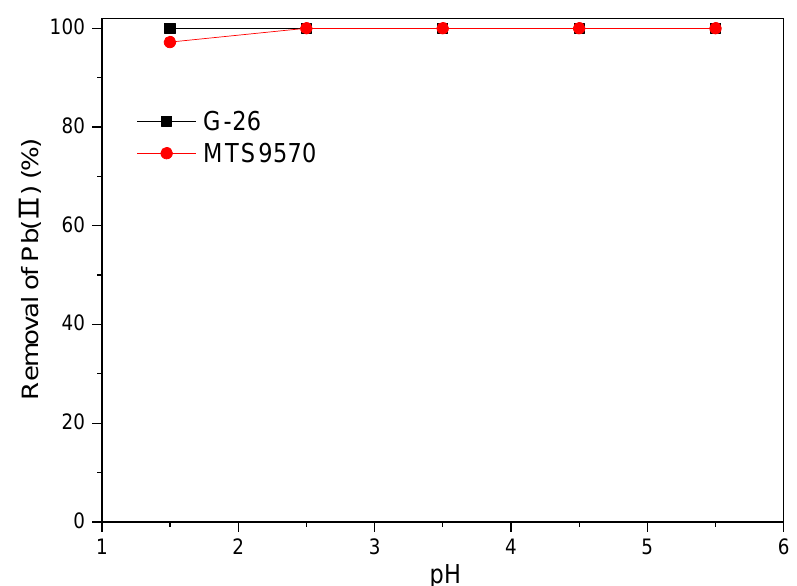
Figure 5. Effect of pH on adsorption of Pb(II) using G-26 and MTS9570 exchange reins at 0.5 g of resin dosage, 20 min agitation time, 150 rpm agitation speed, concentration 1000 mg/L, and temperature 20 °C.